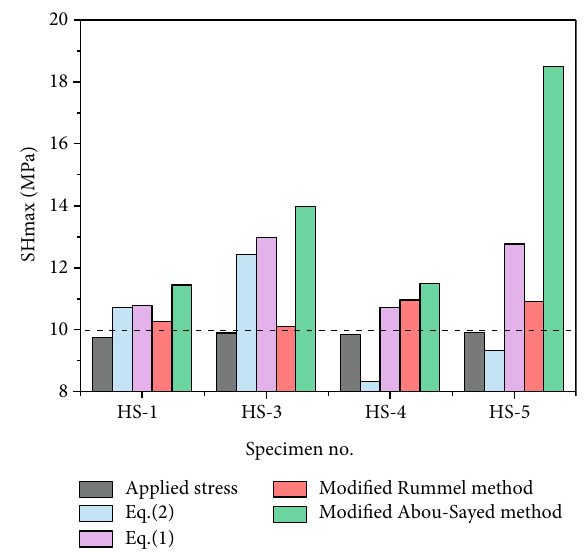
Figure 8: Estimated maximum horizontal principal stresses derived using the considered methods. Equations (1) and (2) correspond to the conventional methods for stress determination, while the modi fi ed Rummel and Abou-Sayed methods are the fracture mechanics approaches, expressed in equations (14) and (13),